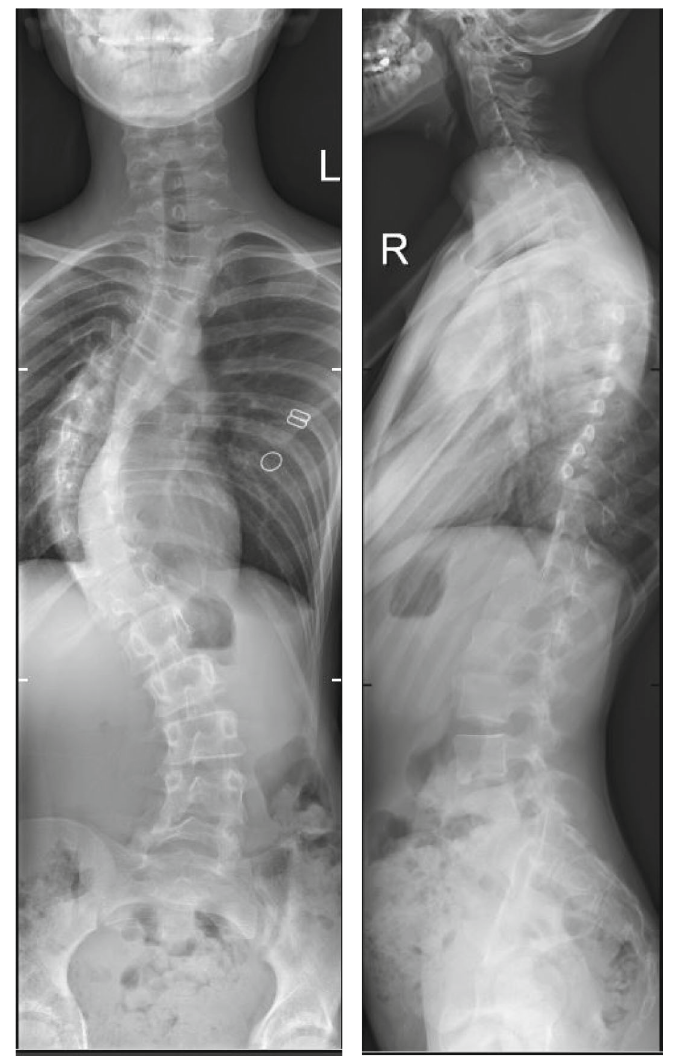
Figure 1: Anteroposterior and lateral X-rays demonstrating right-sided